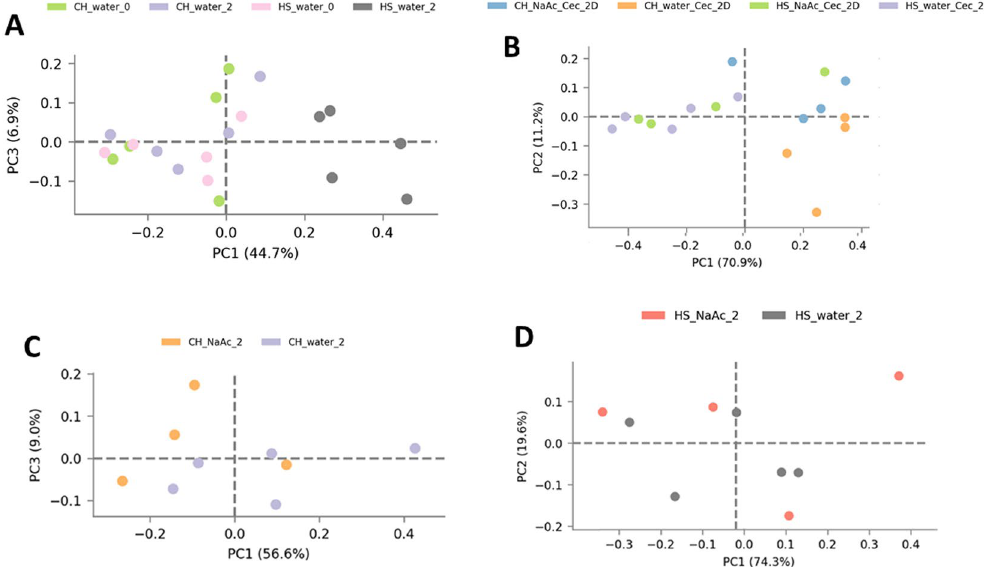
Figure 6. High-sugar diet induces marked microbial dysbiosis. PCA plot of the microbial populations in stool samples from chow and high-sugar fed mice at day -3 (Chow: green, CH_water_0; HS: pink, HS_water_0) and after two days on the diet (Chow: purple, CH_water_2; HS: black, HS_water_2) ( A ). At day -3, all samples clustered together as expected. Following 2 days of a high-sugar diet (HS: black, HS_water_2), stool samples from mice on the high-sugar diet clustered separately from the chow-fed mice (Chow: purple, CH_water_2). Cecal samples in chow and high sugar fed mice after two days are shown in ( B ). Samples from the chow fed mice (Chow: orange, CH_water_Cec_2D) and the chow fed mice receiving acetate (Chow + Acetate: blue, CH_ NaAc_Cec_2D) clustered together while stools from the high-sugar fed (HS: purple, HS_water_Cec_2D) and the high-sugar + acetate (HS + acetate: green, HS_NaAc_Cec_2D) mice also clustered together but apart from the samples from chow fed mice. Stool samples taken after two days on the diet from chow and chow + acetate mice are shown in ( C ). Samples from chow fed (Chow: purple, CH-water_2) and chow fed + acetate (Chow + Acetate: orange, CH_NaAc_2) clustered together. Stool samples taken after two days on the diet in high-sugar and high-sugar + acetate mice are shown in ( D ). Stool samples from high-sugar (HS: black, HS_water_2) and high-sugar + acetate (HS + Acetate: orange, HS_NaAc_2) fed mice also clustered together indicating that acetate did not alter the microbial changes induced by the high-sugar diet. Chow: n = 5; HS: n = 5; Chow + acetate: n = 4; HS + acetate: n =